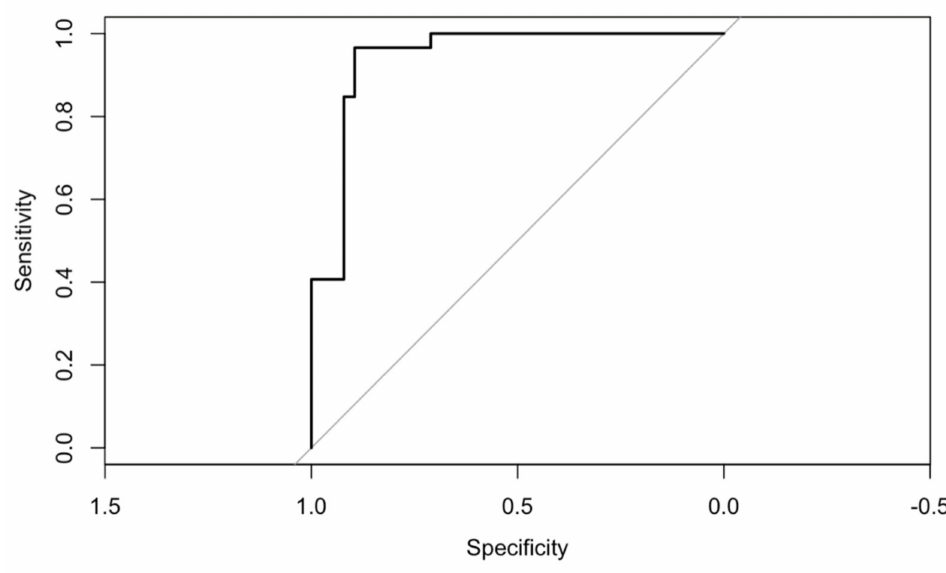
Figure 3. ROC Curve. Logistic Regression Model.